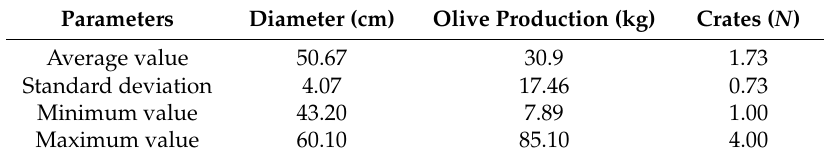
Table 1. Main characteristics of the olive trees observed (“Frantoio” cultivar).